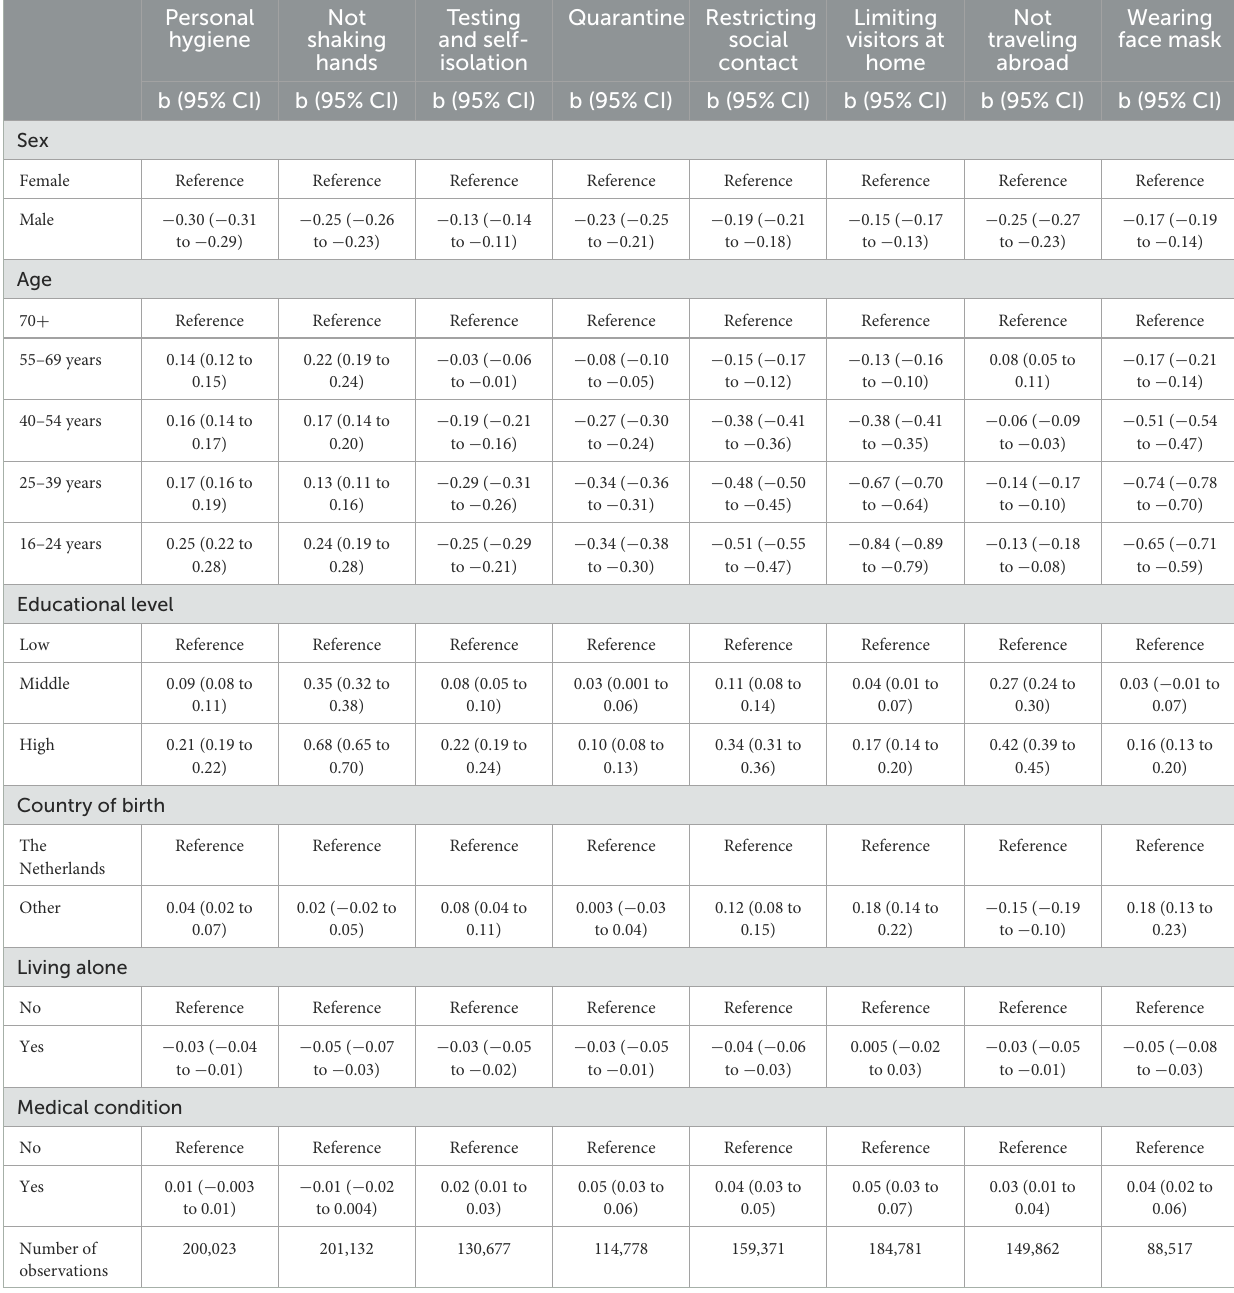
TABLE 4 Multivariable analysis of differences in support of COVID-19 mitigation measures according to participants’ demographic characteristics. Personal Not Testing hygiene shaking and